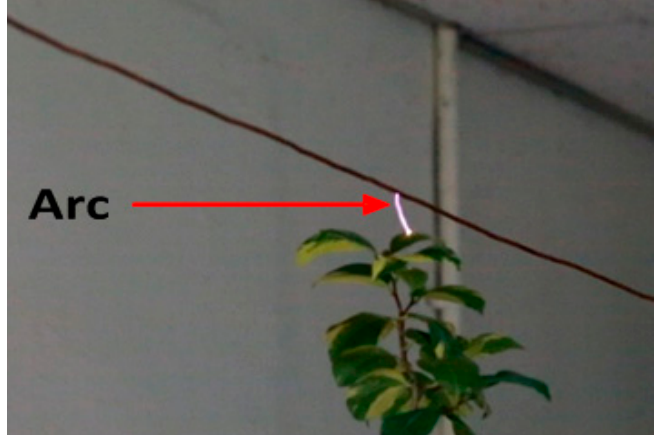
Figure 3. Arc between the conductor and the tree.